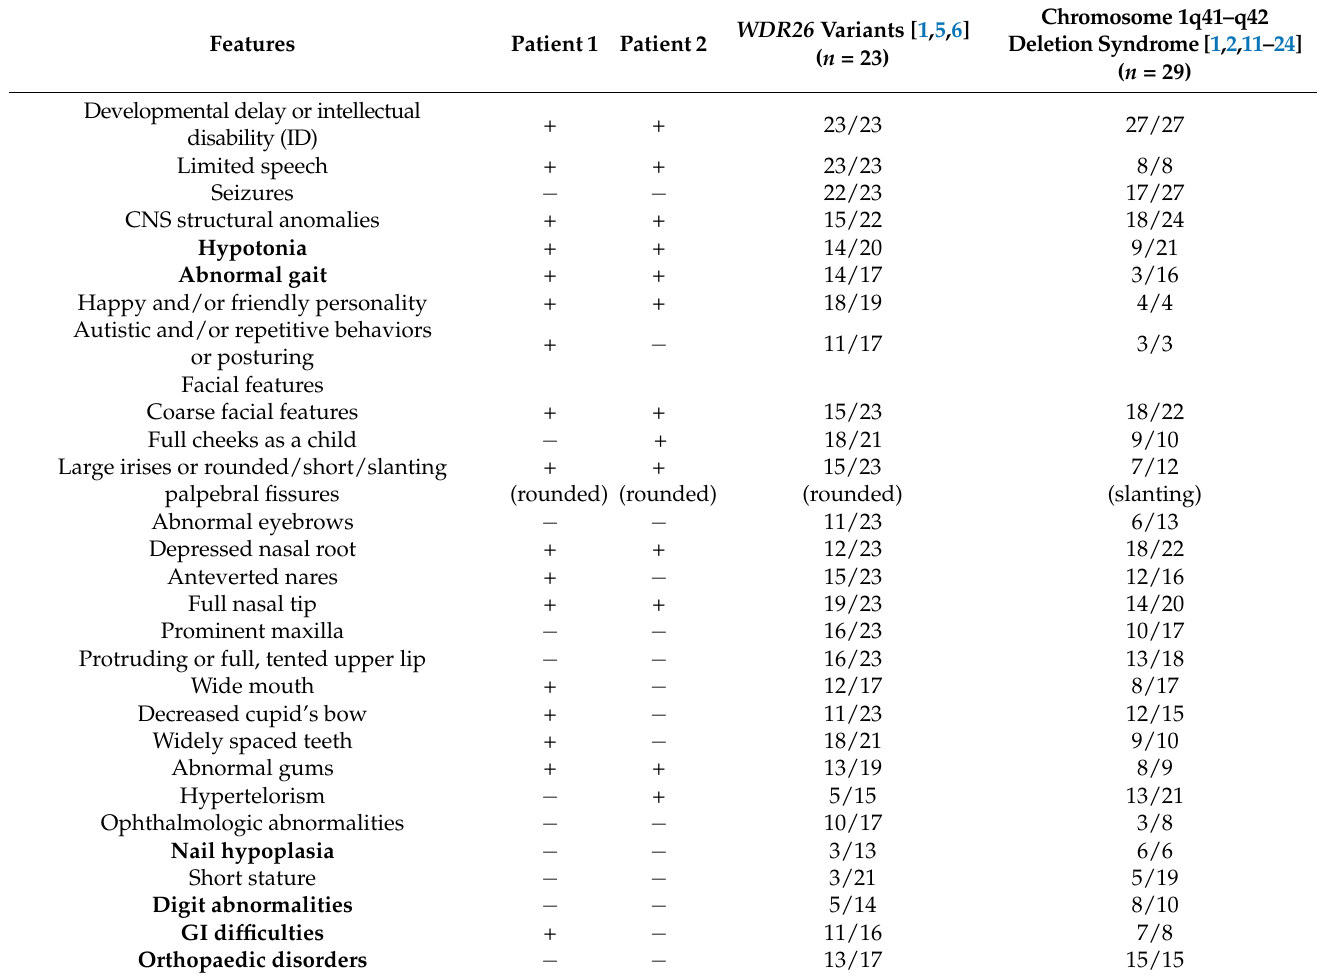
Table 1. Clinical features of patients with WDR26 variants or chromosome 1q41-q42 deletion